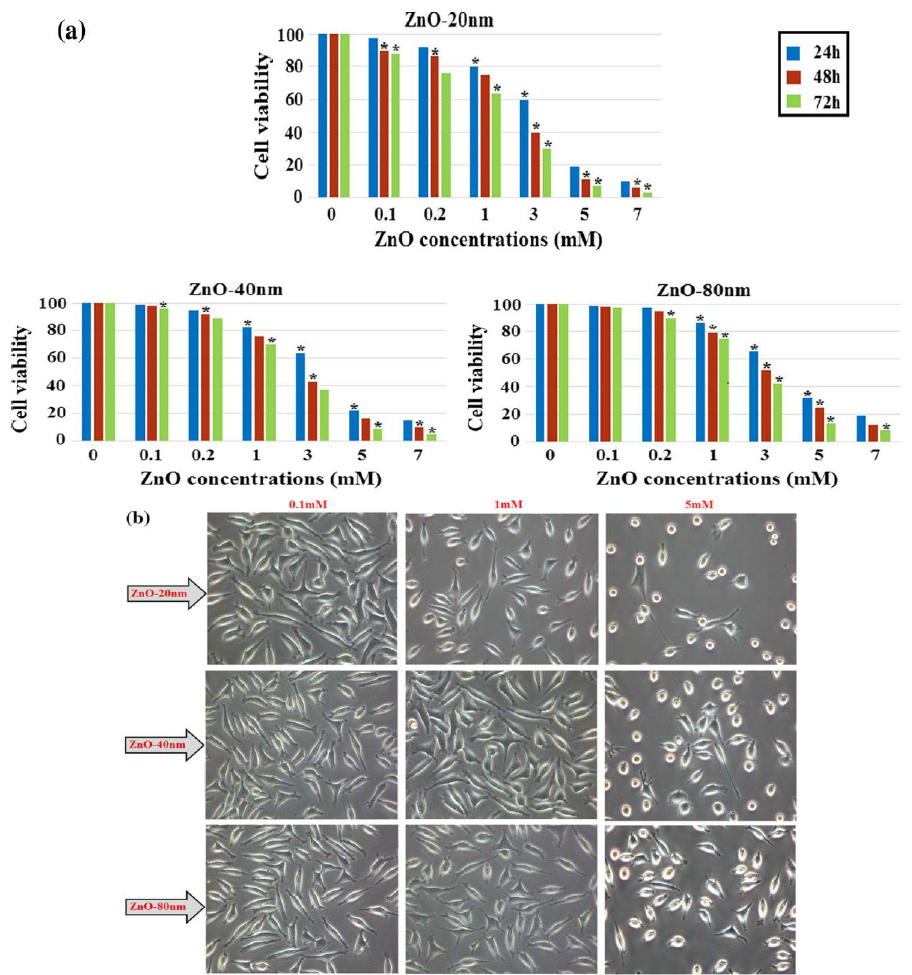
Figure 18. ( a ) Viability of L929 murine fibroblasts treated with nZnO of different sizes and doses for 24, 48 and 72 h. The results are presented as mean ± standard deviation of three independent experiments. * p < 0.05. ( b ) Optical images showing the morphologies of L929 cells exposed to nZnO of different sizes and doses for 48 h. Images are taken with x20; arrow scale bar: 20 µm. Reproduced from [144] with permission of Springer Nature.